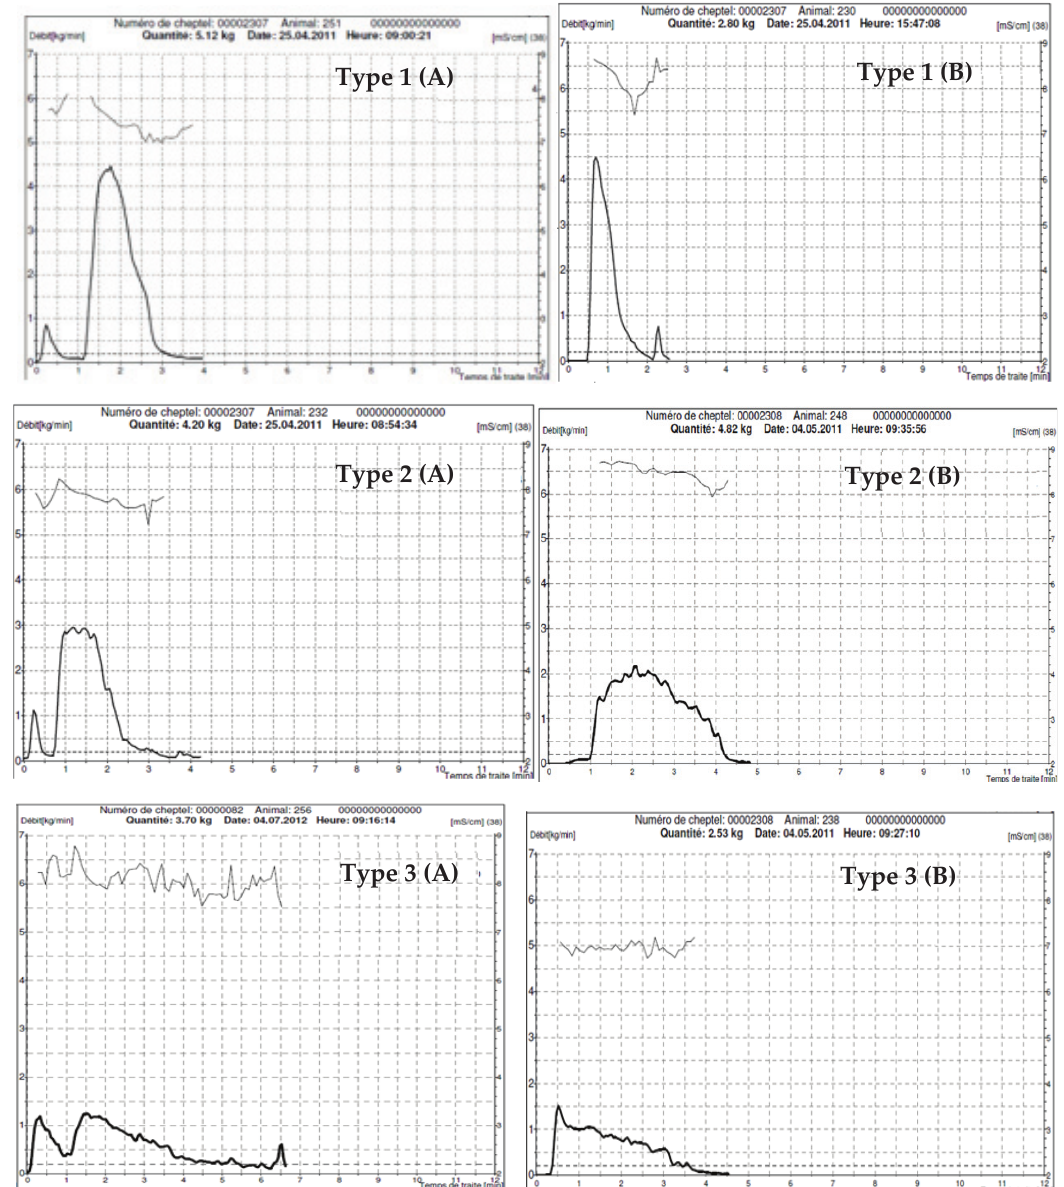
Figure 2. Different milk flow patterns with ( A ) and without ( B ) bimodality recorded by lactocorder ® in dromedary camels.